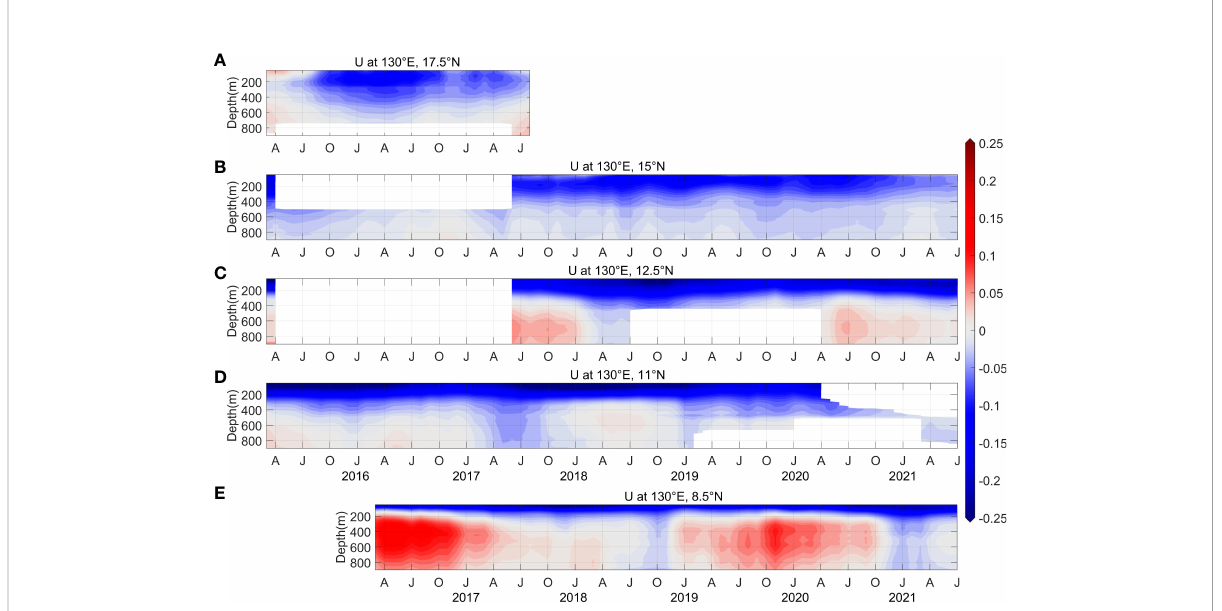
FIGURE 2 Time series of zonal velocity (m/s) measured by the mooring ADCPs at (A) 17.5°N, (B) 15°N, (C) 12.5°N, (D) 11°N and (E) 8.5°N along 130°E. All the time series have been smoothed with a 1-year low-pass fi